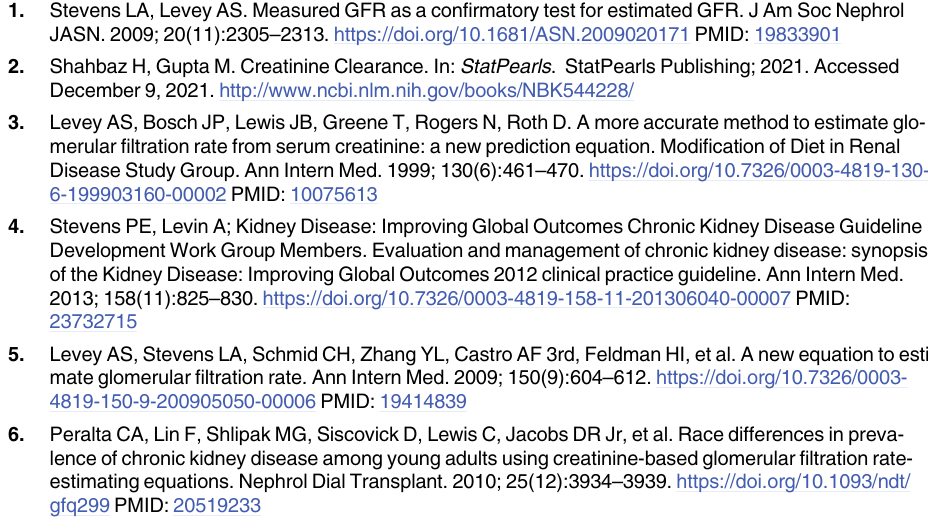
and MDRD studies with and Cr